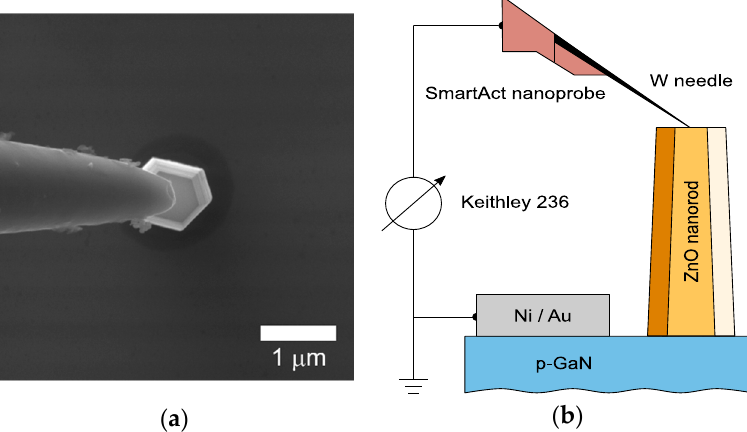
Figure 2. ( a ) SEM image of the nanomanipulator needle in contact with a single ZnO nanorod. ( b ) The experimental set-up for the electrical probing of a single nanorod in SEM.